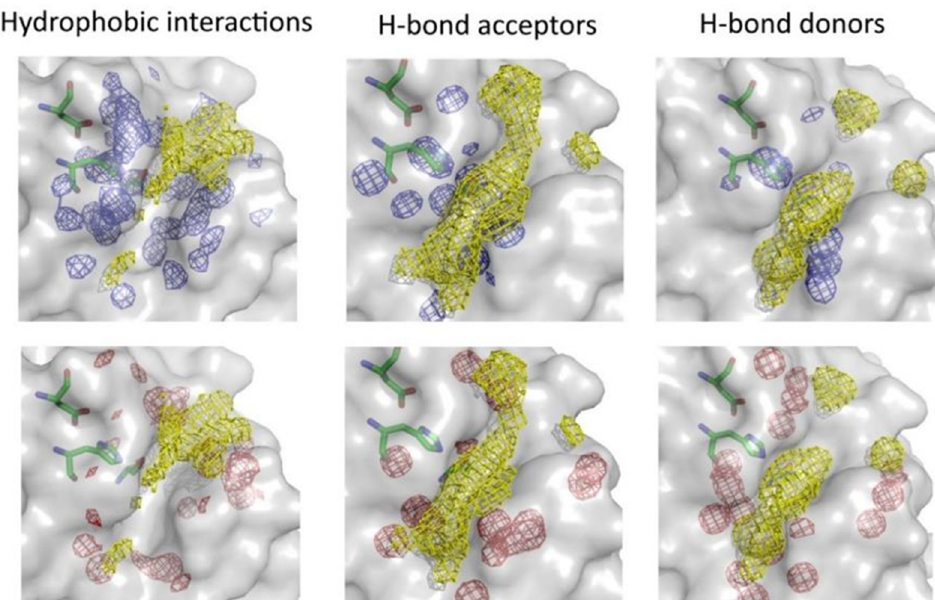
Figure 2. MIFs of Thc_cut1 conserved (blue) and absent (red) in CaLB structure. The representation takes into account hydrophobic interactions (left) and H-bond capabilities (center and right). The reference structure on the back is Thc_cut1 1, where the catalytic triad is visible. The zones potentially occupied by functional groups of the substrate matching the mentioned probe are indicated in yellow and are represented by pseudoMIFs.